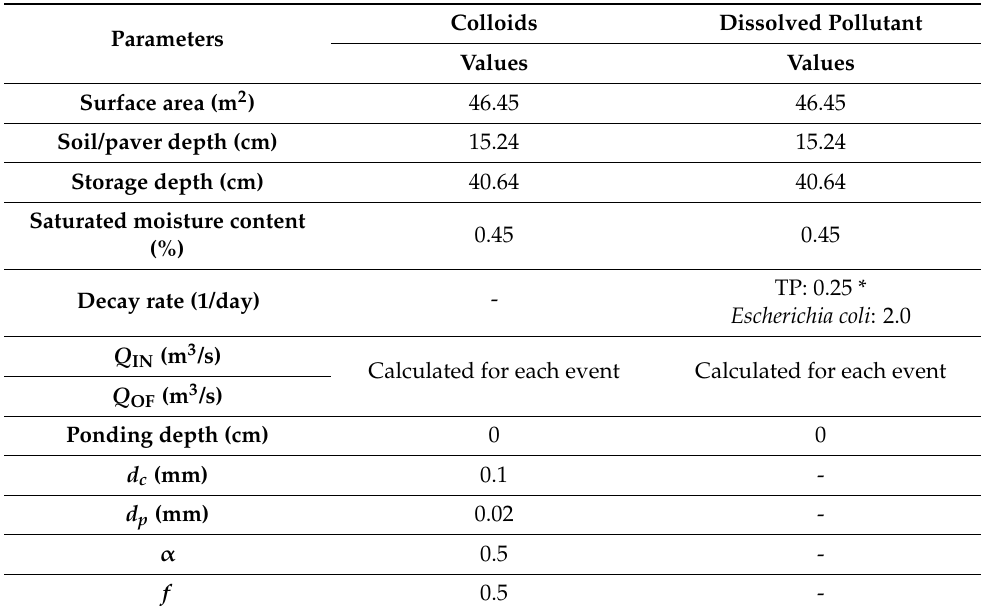
Table 2. List of parameters and their values used in the water quality module by pollutant type.